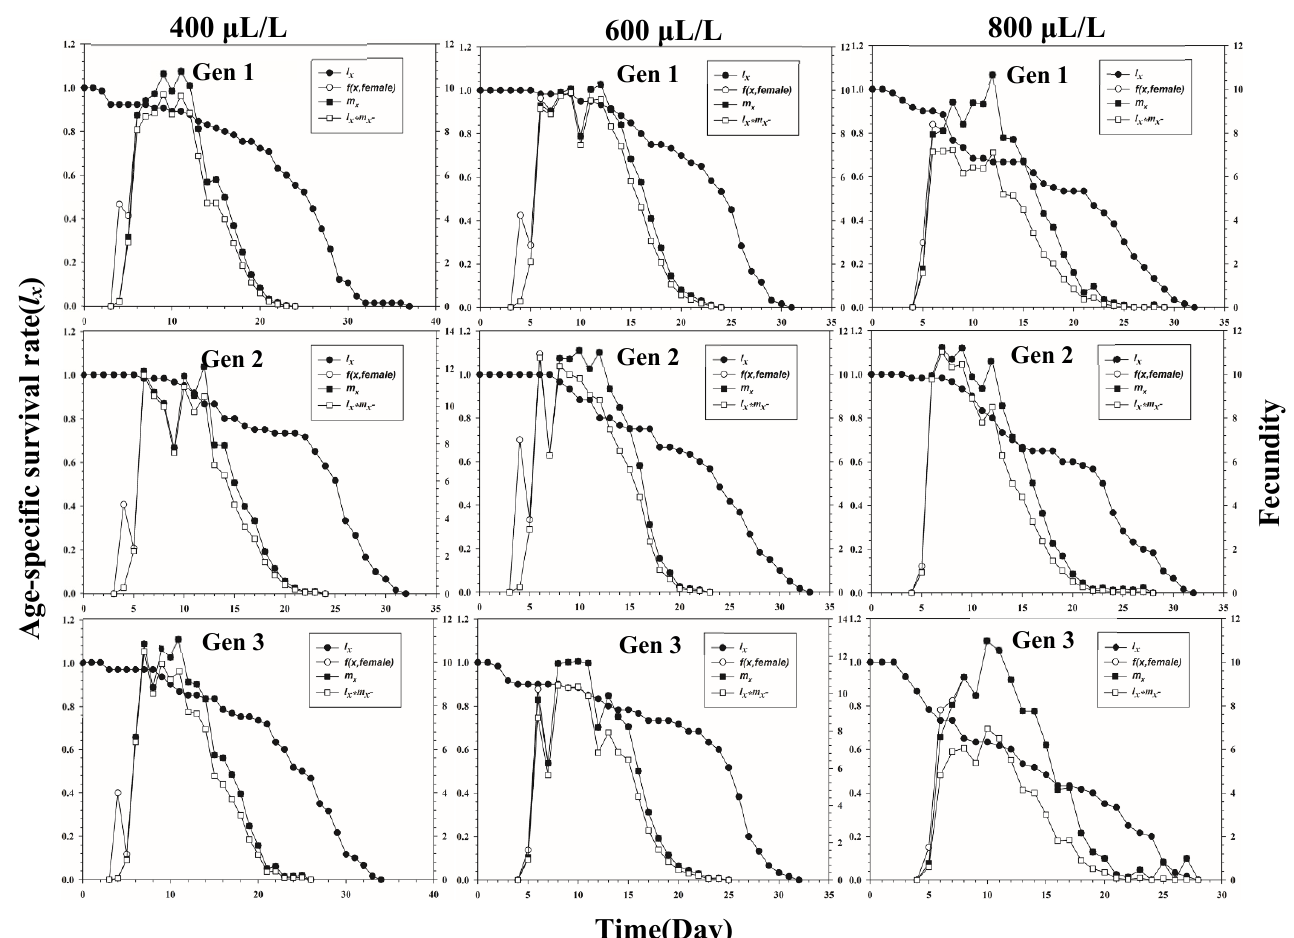
Figure 3. Age-specific survival rate ( l x ) (left y -axis), age-stage-specific fecundity ( f ( x , female)) (right y -axis), age-specific fecundity ( m x ) (right y -axis), and age-specific maternity ( l x m x ) (right y -axis) of three successive generations of L. erysimi under three CO 2 treatments.